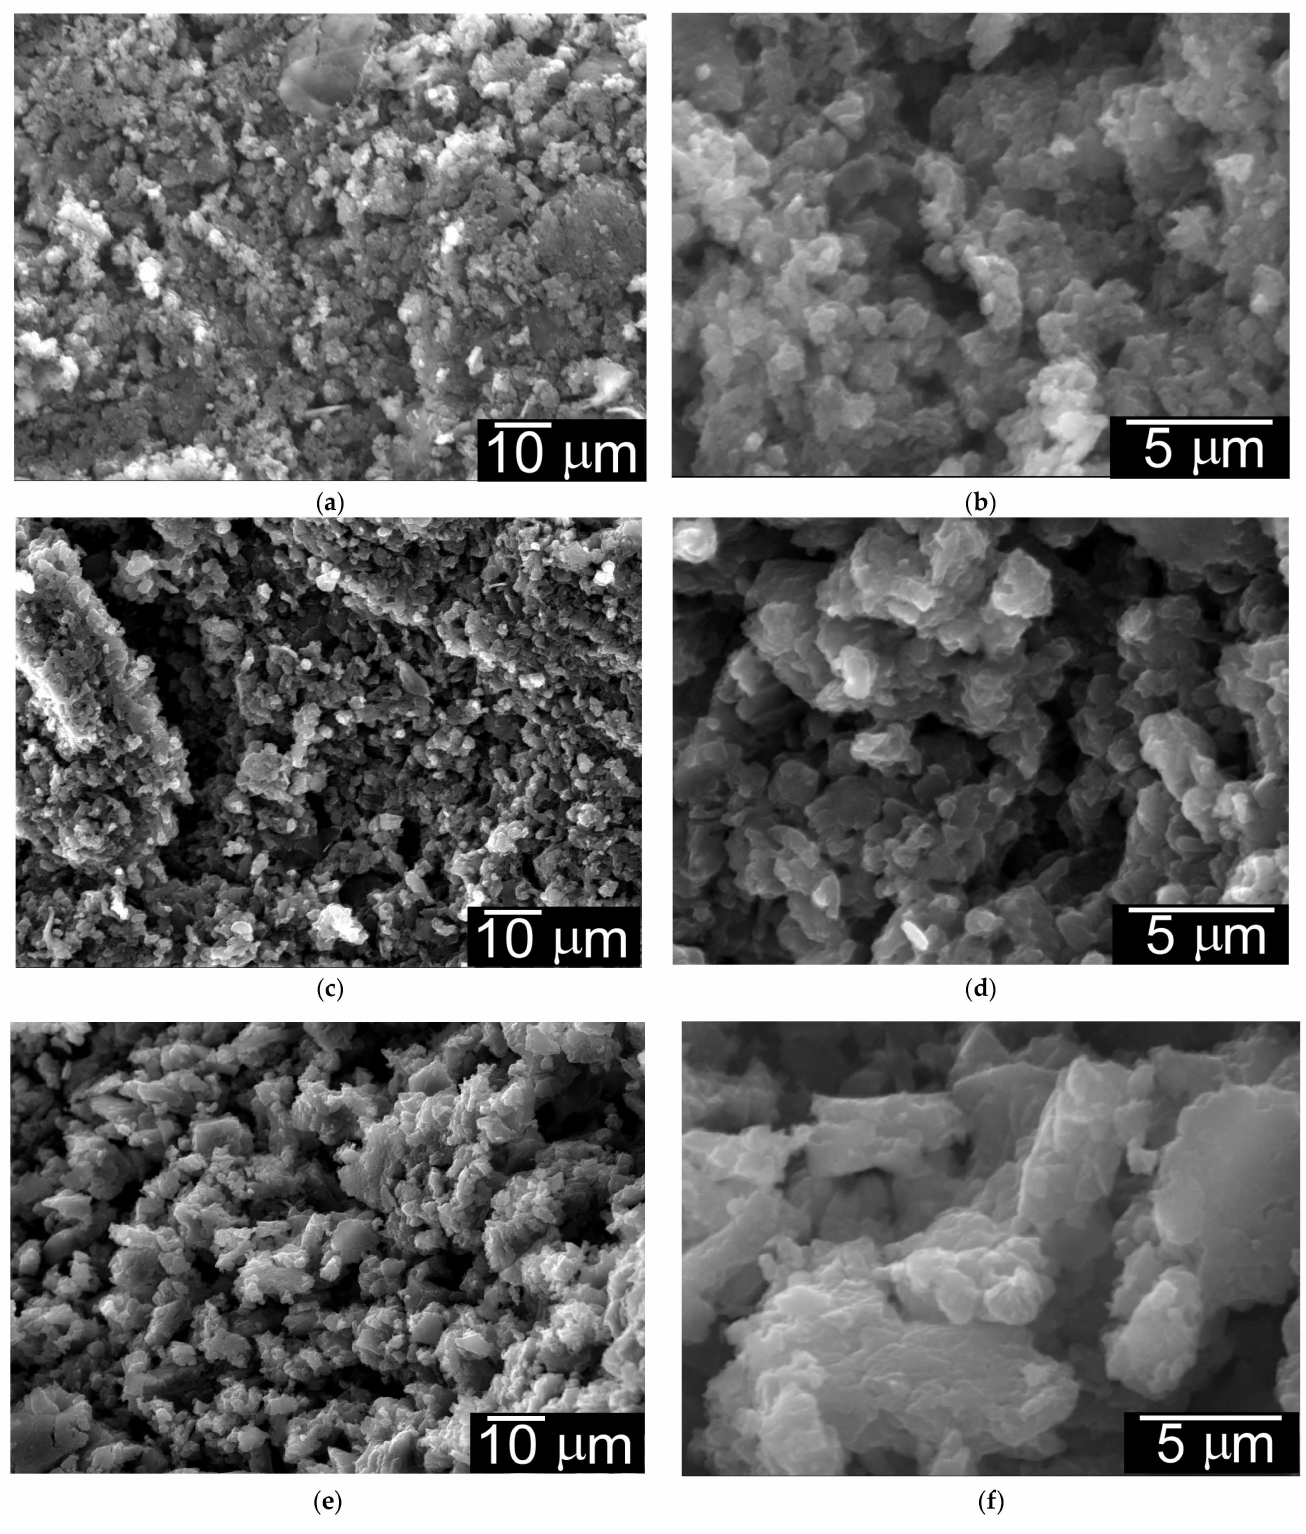
Figure 19. SEM images of polymer composites. ( a , b ) N05, ( c , d ) N1, and ( e , f ) N2. Increasing the of quantity of the fucoidan element in the composite increased the size of the fine